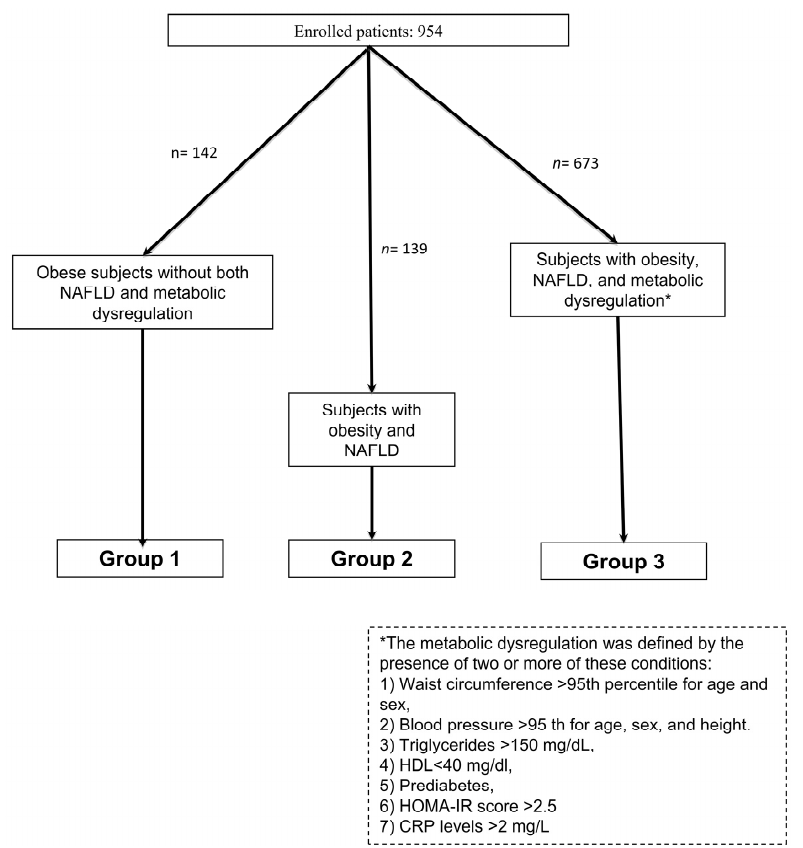
Figure 1. Flow chart summarizing the criteria for the inclusion in the 3 different groups. To define the increased cardiovascular risk in our population, we used NAFLD and criteria for metabolic dysregulation because of their close intertwining with cardiovascular disease